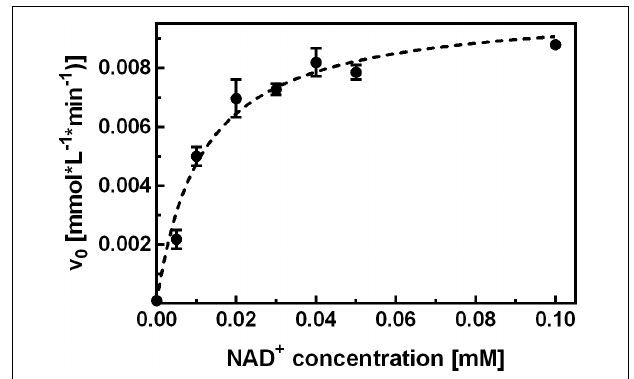
FIGURE 3 | Kinetic characterization of NAD + binding. Apo-SAHase was pre-incubated with varying NAD + concentrations and activity was measured in the hydrolytic direction. Hyperbolic fitting (dashed curve) yielded an EC 50 of 11.2 ± 1.4 µ M ( r 2 = 0.959) for NAD + . Displayed are average values and standard deviations of replicates ( n =